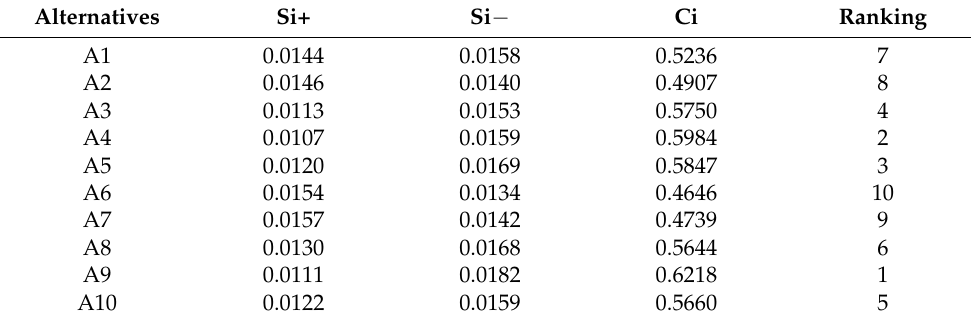
Table 5. Ranking value from the TOPSIS